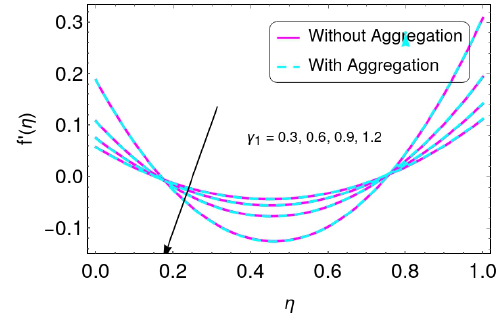
Figure 7. Characteristics of γ 1 for distribution f (cid:48) ( η ) .